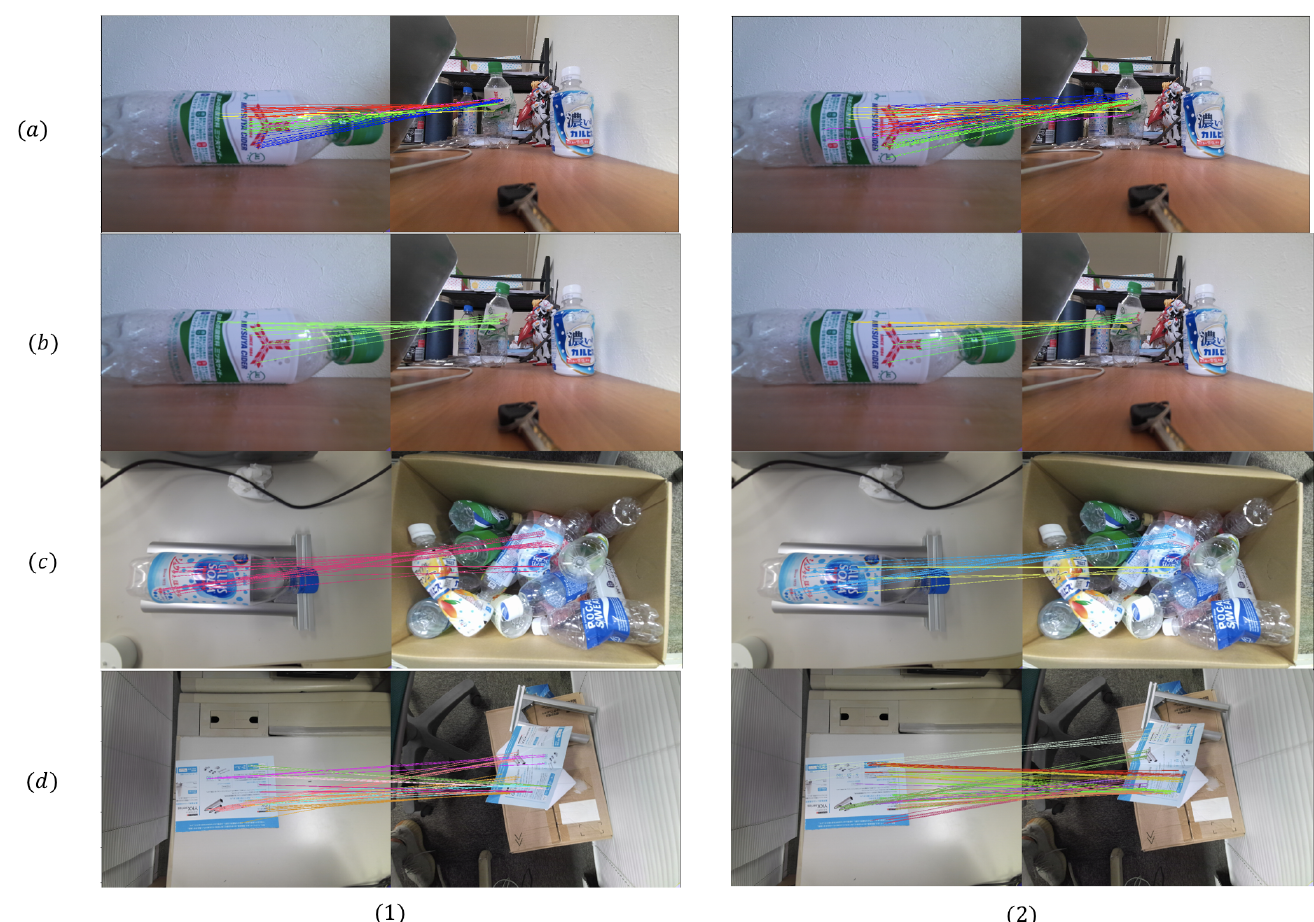
Figure 15. Result of clustering: ( 1 ) the unweighted graph clustering method of [41]; ( 2 ) our weighted graph cluster- ing method; ( a ) bottle with low deformation; ( b ) bottle with high deformation; ( c ) bottle in complex environment; ( d ) deformed